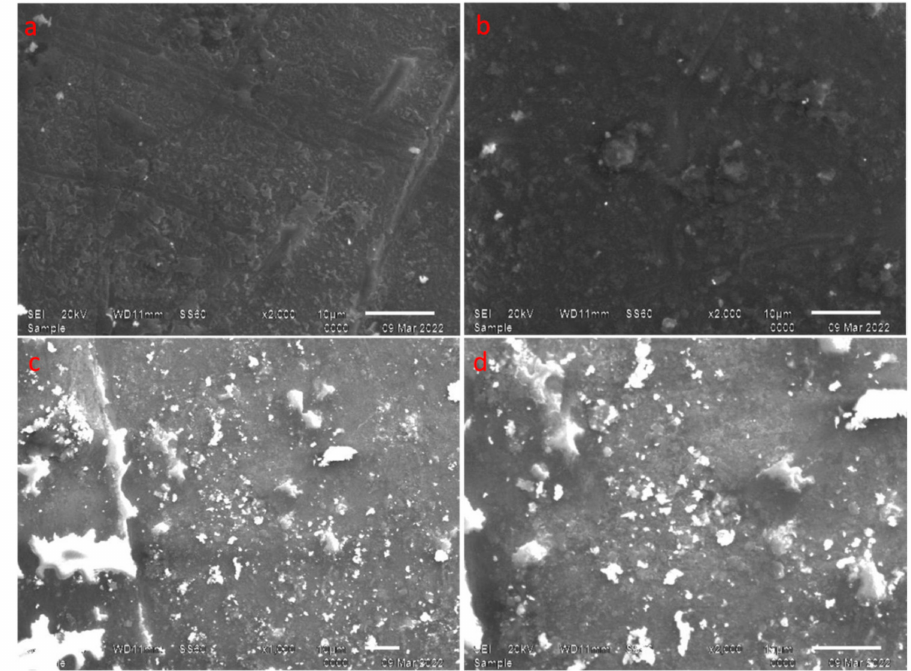
Figure 5. SEM image of ( a ) un-treated PANI/PbS and ( b – d ) the films irradiated by 5 × 10 16 , 10 × 10 16 , and 15 × 10 16 ions/cm 2 ,